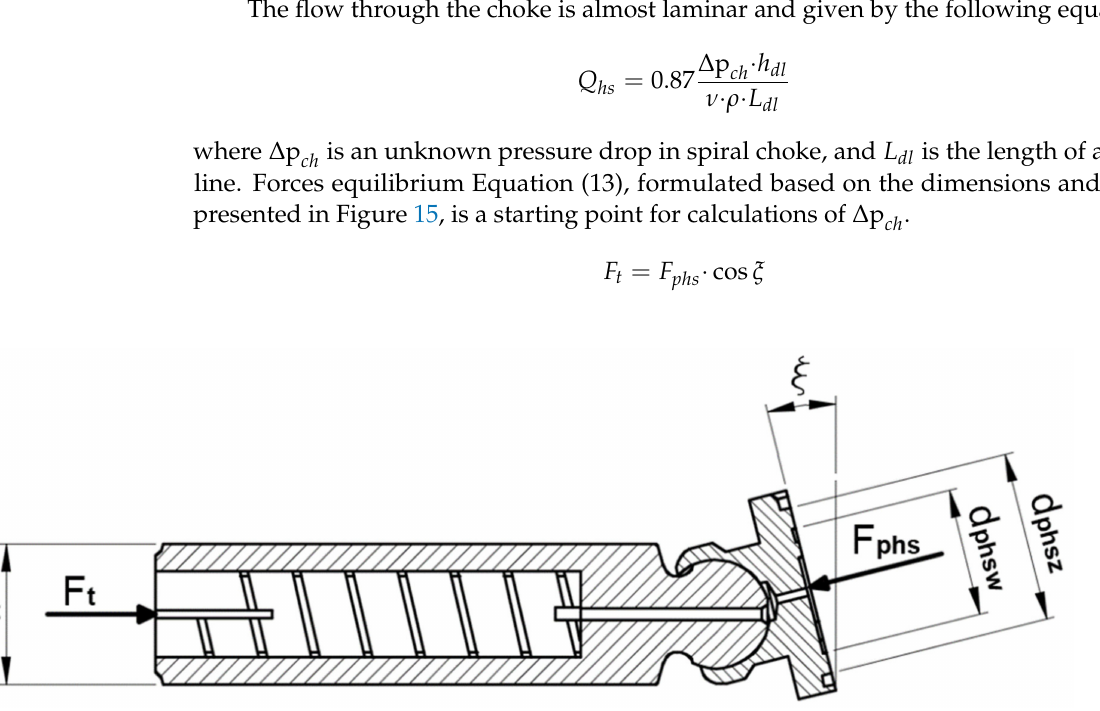
Figure 15. Load distribution on the piston and slipper